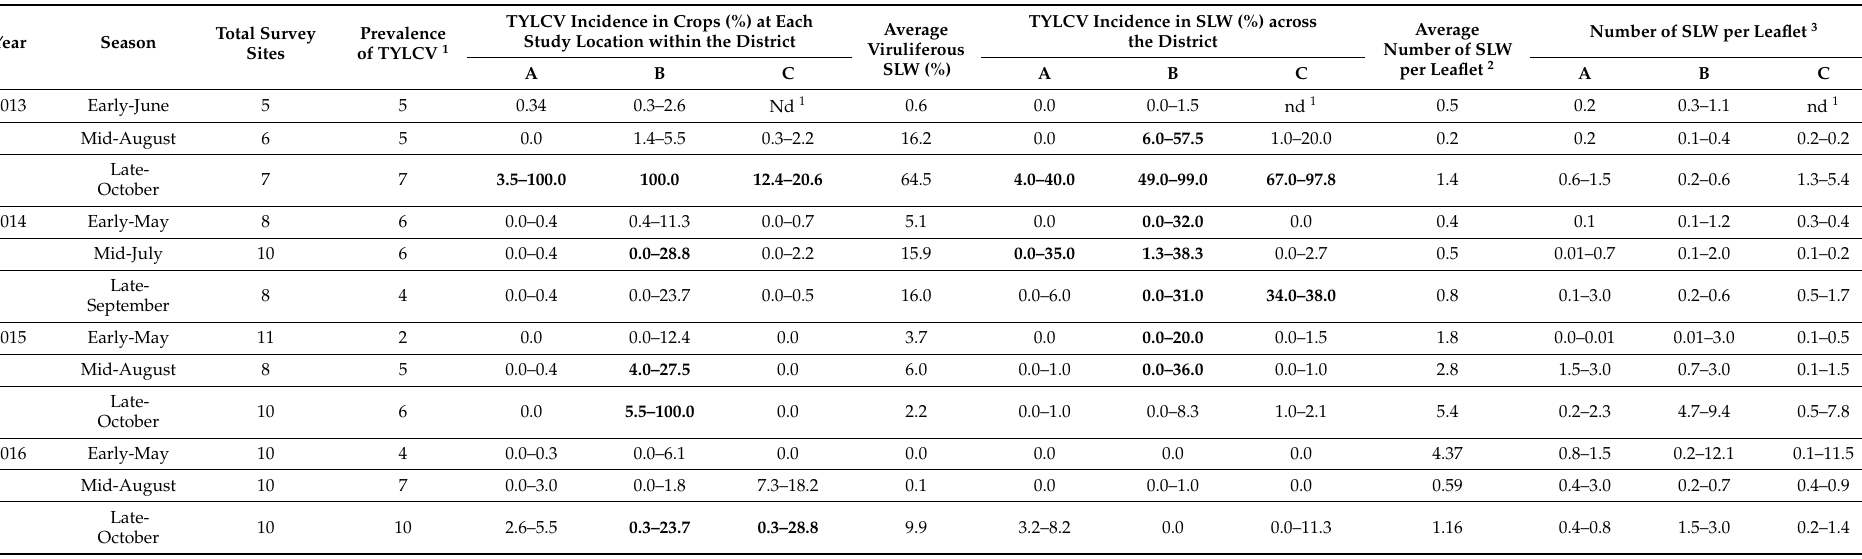
Table 2. Summary of tomato yellow leaf curl virus (TYLCV) incidence in crops and silverleaf whitefly (SLW) populations and the number of adult SLW detected during surveys. The total number of sites surveyed in each area (A, B, and C) and for each time point is listed with the prevalence of TYLCV, the average percent of viruliferous SLW, and average SLW per leaflet listed across the sites. The incidence of TYLCV in crops and SLW populations is data given as the range from minimum to maximum. Data where TYLCV incidence is 20% or greater is highlighted in